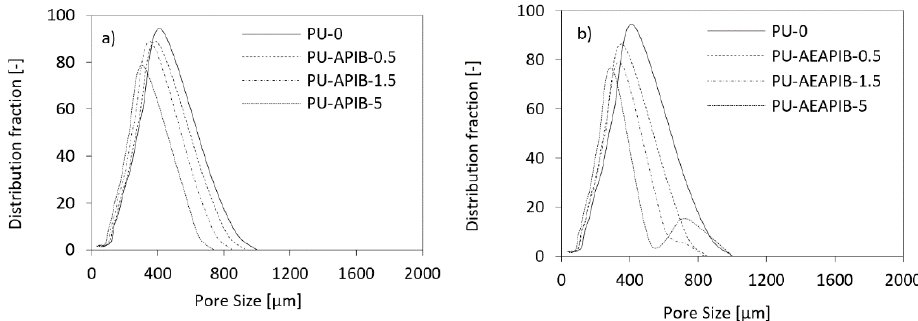
Figure 7. Cell size distributions of RPUFs modified with ( a ) APIB-POSS and ( b ) AEAPIB-POSS.